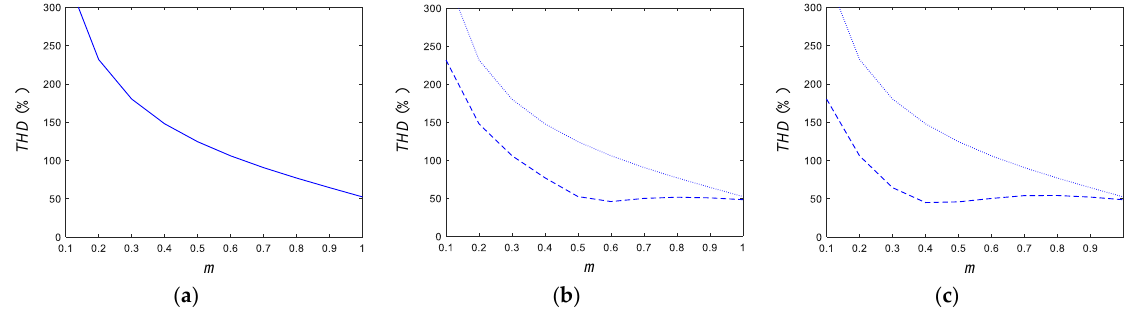
Figure 9. Total harmonic distortion of the line-to-line voltage as a function of the modulation index. Dotted lines correspond to design A, dashed lines correspond to design B, and solid lines correspond to both design A and design B. ( a ) EV 1 . ( b ) EV 2 . ( c ) EV 3 .